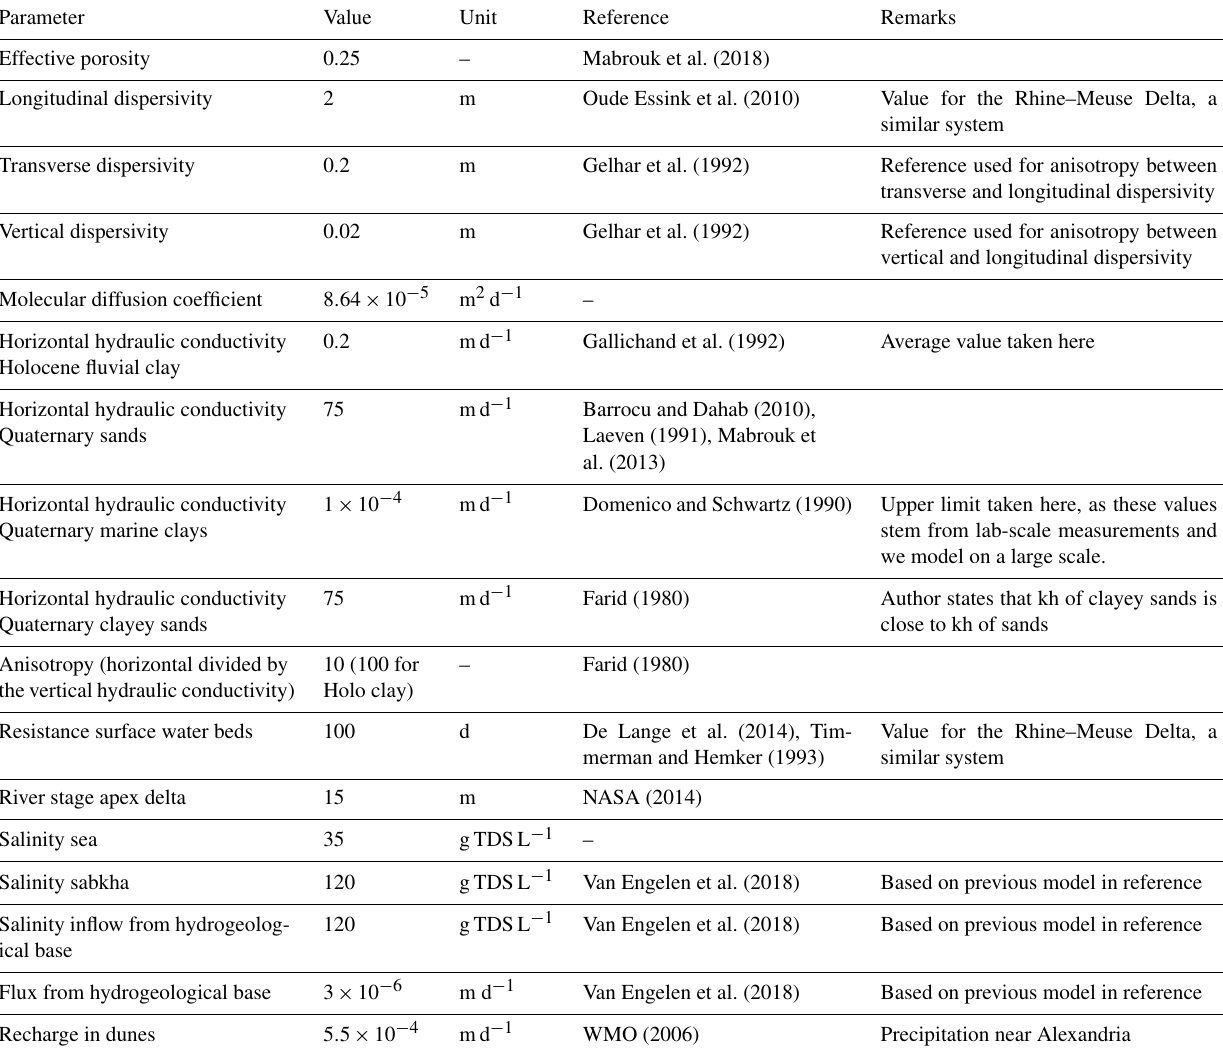
Table 3. Parameters fixed throughout